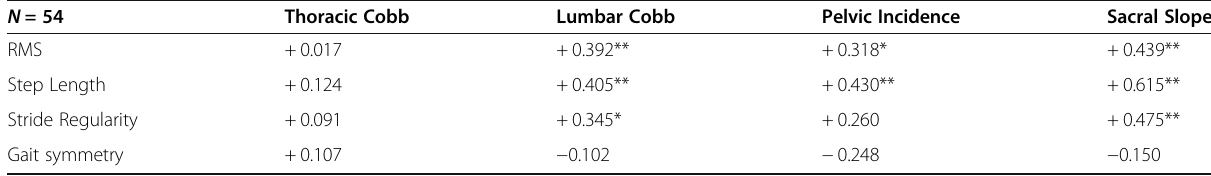
Table 3 Correlations of spine and the pelvis angles with accelerometer-derived data in the anteroposterior plane N = 54 Thoracic Cobb Lumbar Cobb Pelvic Incidence Sacral Slope RMS + 0.017 +